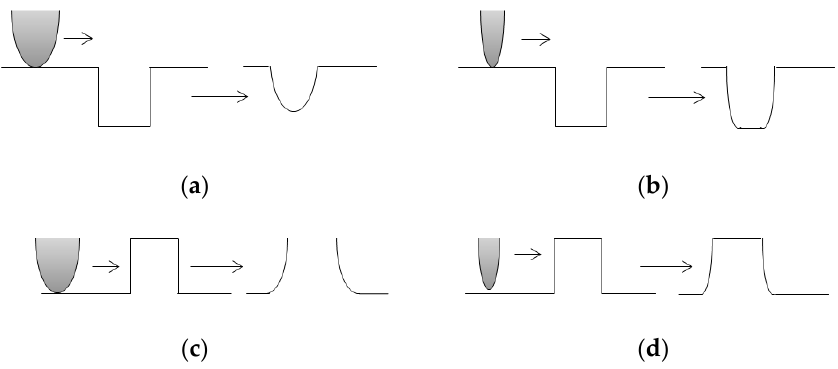
Figure 13. AFM operation (adapted from [75]) ( a , b ) smaller representation of indentations and ( c , d ) larger representation of elevations.